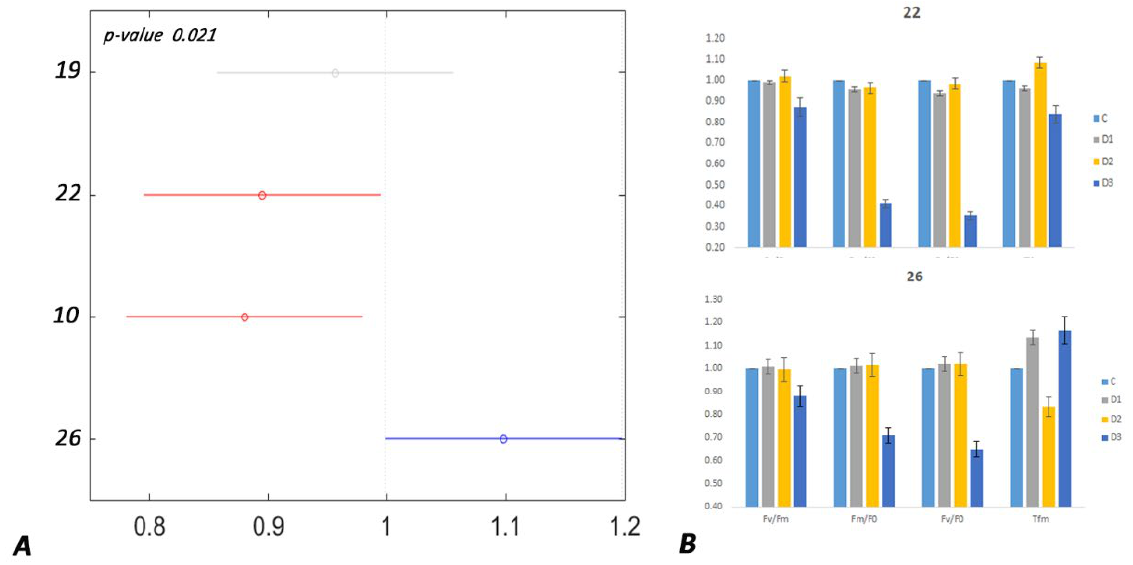
Figure 2. Photosynthetic performance of common bean lines during drought stress. ( A ) Visualization of two-way ANOVA multiple comparisons between the photosynthetic performance of selected common bean line numbers: 19, 22, 10, and 26 shown on the y-axis of the plot. The p -value for the model effect (Prob > F) is also shown in the left corner of the plot. The blue bar is the comparison interval for the means of measured photosynthetic parameters e.g., Fv/Fm, Fm/F 0 , Fv/F 0 , and Tfm of line 26 with the other three lines. The red bars are comparison intervals of lines 22 and 10 that significantly differ from line 26 and grey bar show the comparison interval of line 19, which does not significantly differ from all lines. ( B ) Changes in photosynthetic activity of line 22 (upper bars) and line 26 (lower bars) in response to drought. Bar plots represent the averaged fold changes of each parameter in each state of drought (e.g., D1, D2, D3) compared to the control—well watered state (C). Error bars represent standard errors from triplicates.